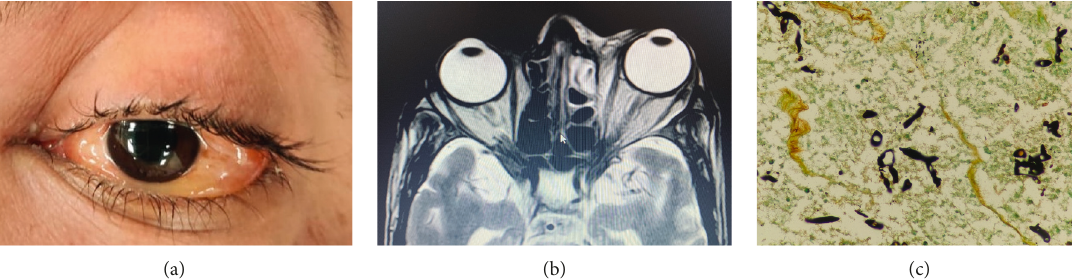
Figure 1: Picture showing lid edema and ptosis of left eye lid (a) with MRI showing mucormycosis deposits in the left paranasal sinuses and orbit (b). Staining with Grocott methenamine silver stain showing septate hyphae of mucormycosis